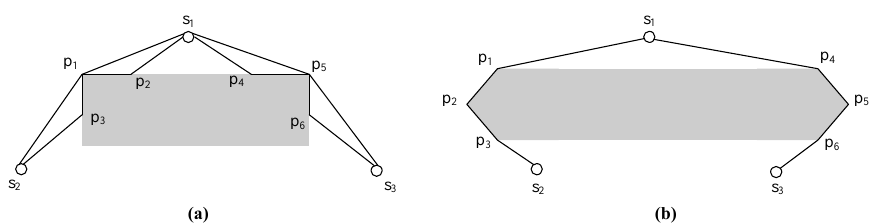
Figure 1. The shortest paths around the obstacle w.r.t ( a ) when there is only one point; ( b ) when there are more points sitting in the middle.